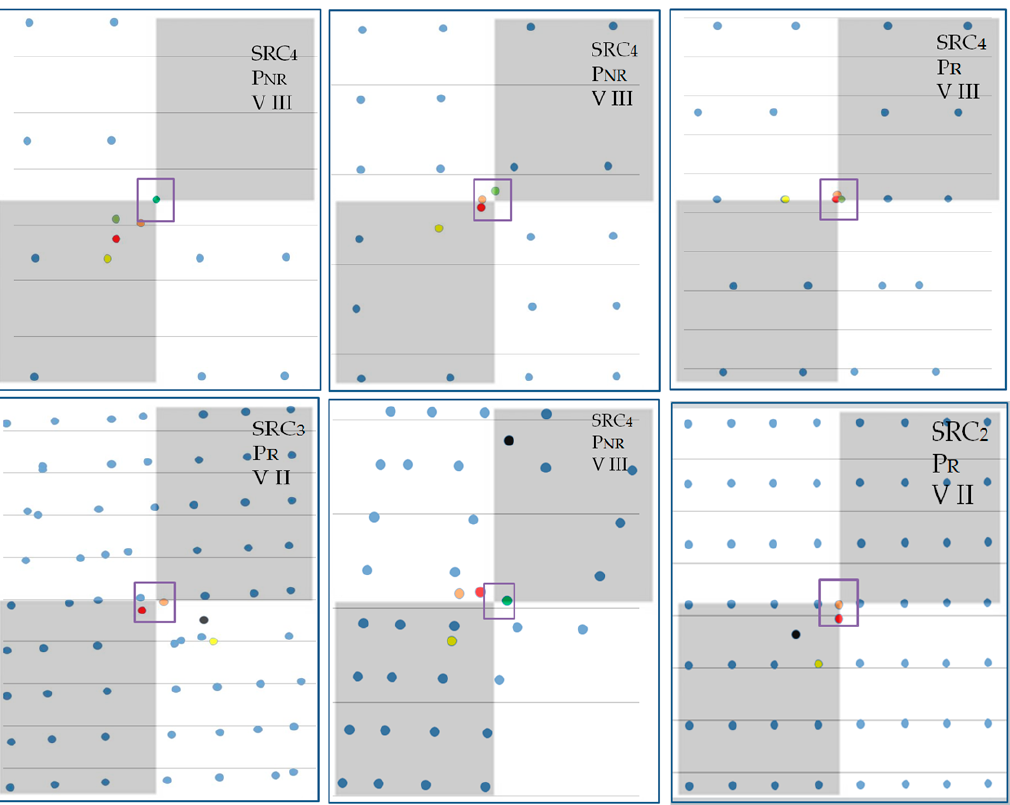
Figure 14. Final results for the chosen targets in comparison to the real target image. Upper—low-quality scans, lower—regular and irregular point distribution. Black dots—automatic identification, yellow—manual, red— variant I, orange— variant II, green—variant III.